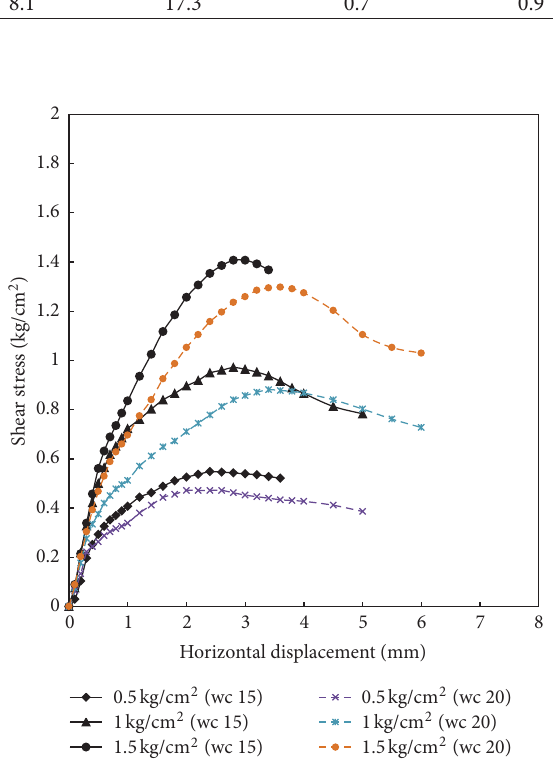
F5:Shearstressversushorizontaldisplacementobtainedfrom direct shear